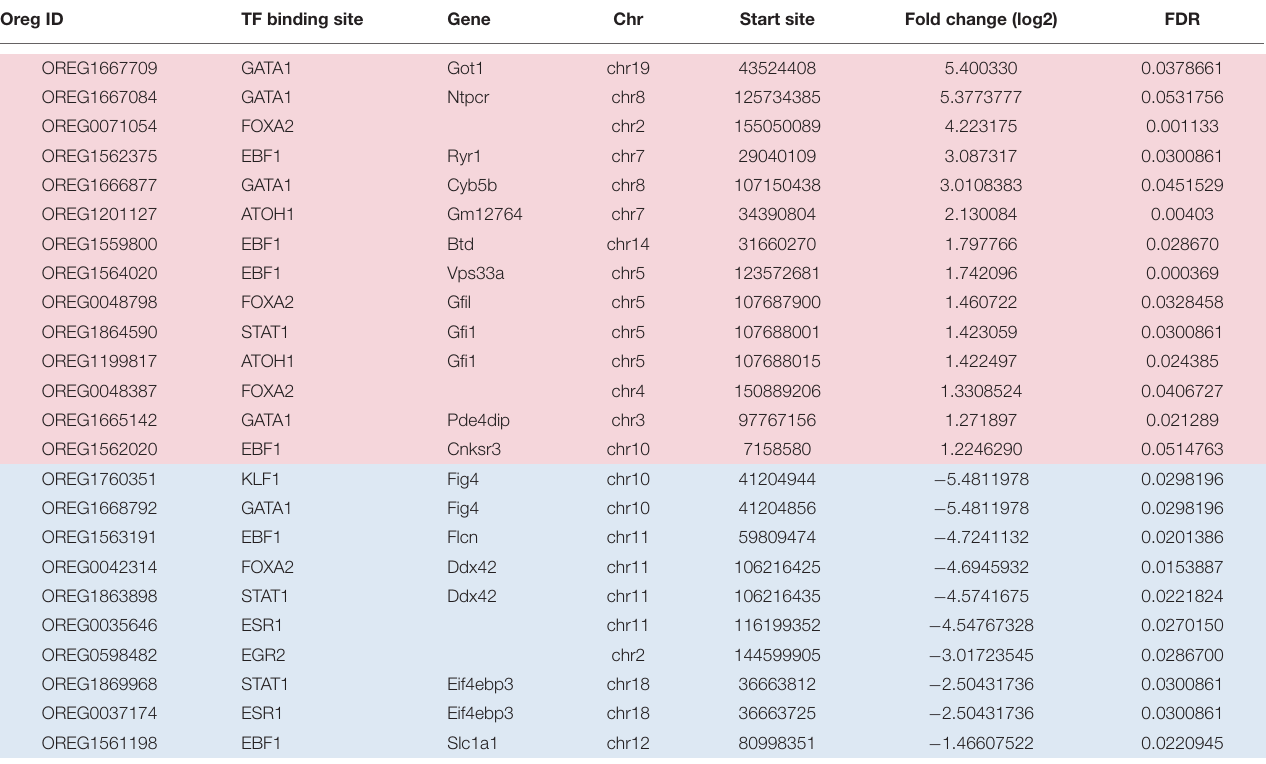
TABLE 2 | Transcription factors associated with DMRs from regulatory regions in the continuous exposure group. Oreg